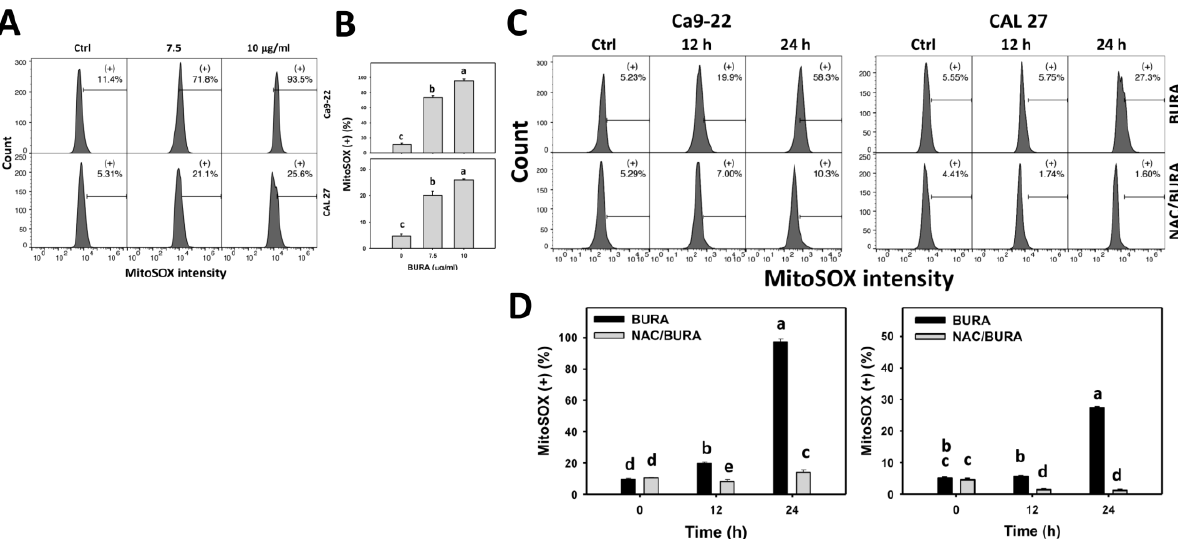
Figure 6. BURA causes MitoSOX production in oral cancer cells. ( A , B ) MitoSOX pattern and quantification. Oral cancer cells (Ca9-22 and CAL 27) were treated with BURA (control (0.1% DMSO), 7.5 µ g/mL (25.3 µ M), and 10 µ g/mL (33.8 µ M), 24 h). (+) located within the patterns represent MitoSOX (+). ( C , D ) NAC effect on MMP pattern and quantification. After NAC treatment (10 mM, 1 h), cells were treated with BURA (10 µ g/mL) for 0 (control), 12 and 24 h. Data, mean ± SD ( n = 3). Data top-labeled with non-overlapping lower-case letters differ significantly according to multi-comparisons ( p <